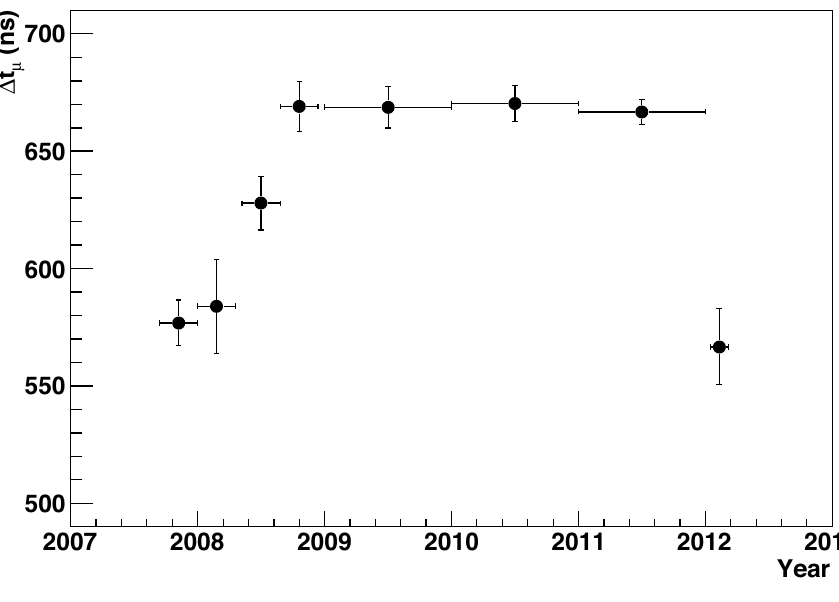
Figure 5. Distribution of the Δ t μ = t LVD − t OPERA . For each year all events are grouped into one single point, but for 2008 they are subdivided into three periods: before May, May-August, and after